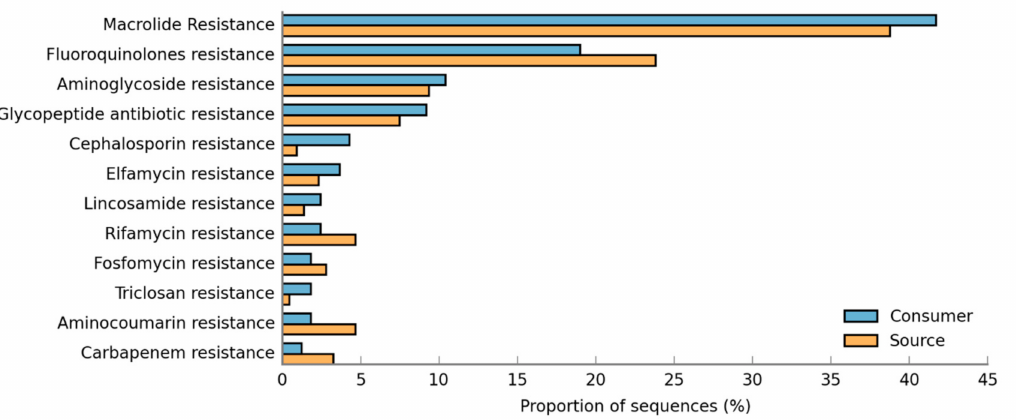
Figure 8. Relative percentage bar plot of antibiotic resistance gene classes identified in consumer and source